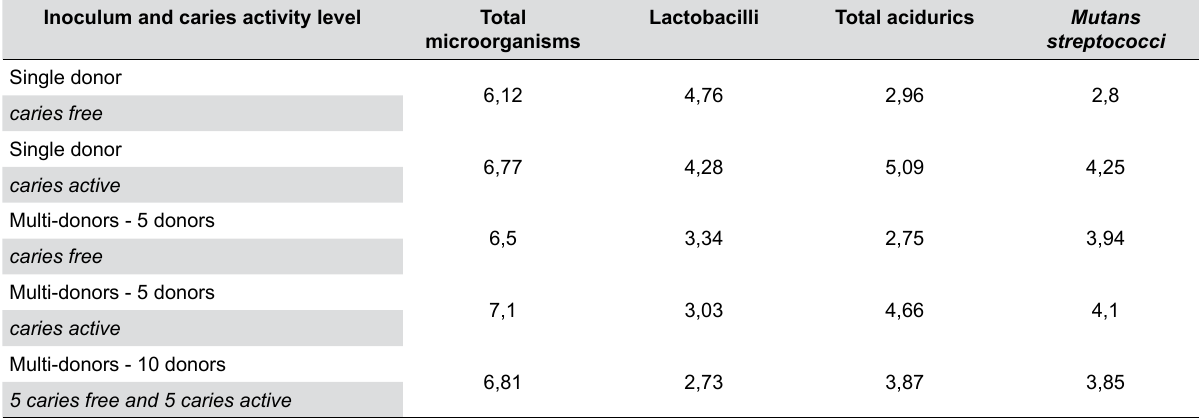
Table 1- Baseline microbiological counts according to caries activity and inoculum levels (CFU log ml -1